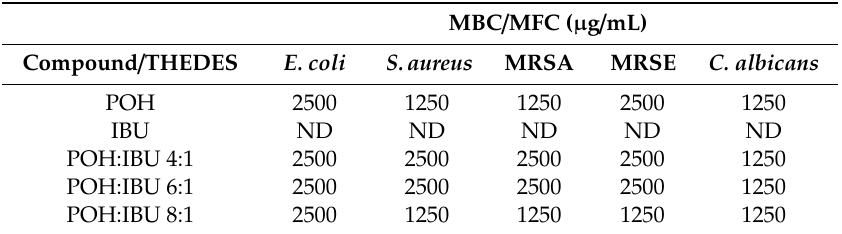
Table 4. MBC/MFC values of the individual counterparts and THEDES. Results are presented by Table 4. MBC / MFC values of the individual counterparts and THEDES. Results are presented by formulation for each microbial strain tested. ND—not dissolved. formulation for each microbial strain tested. ND—not dissolved.